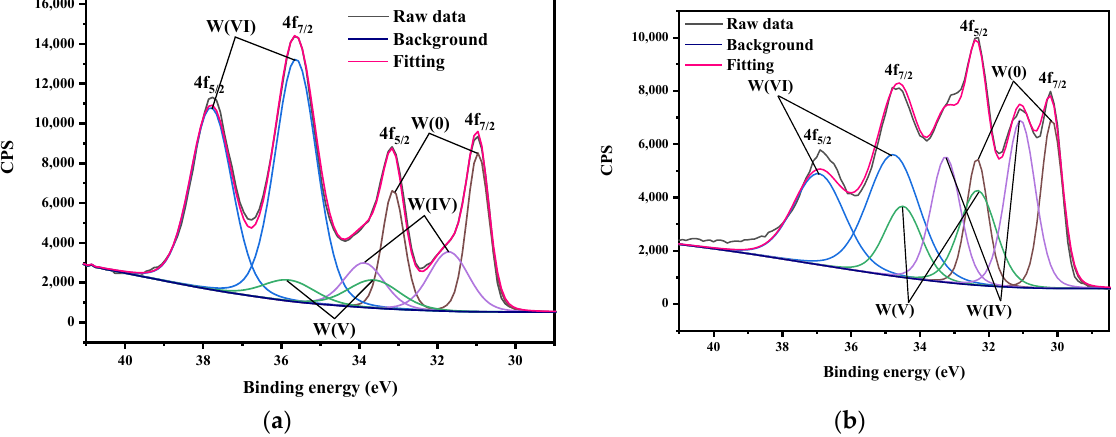
Figure 5. The deconvolution of spectra for the Ca 2p levels of tungsten in tap water for 60 days.